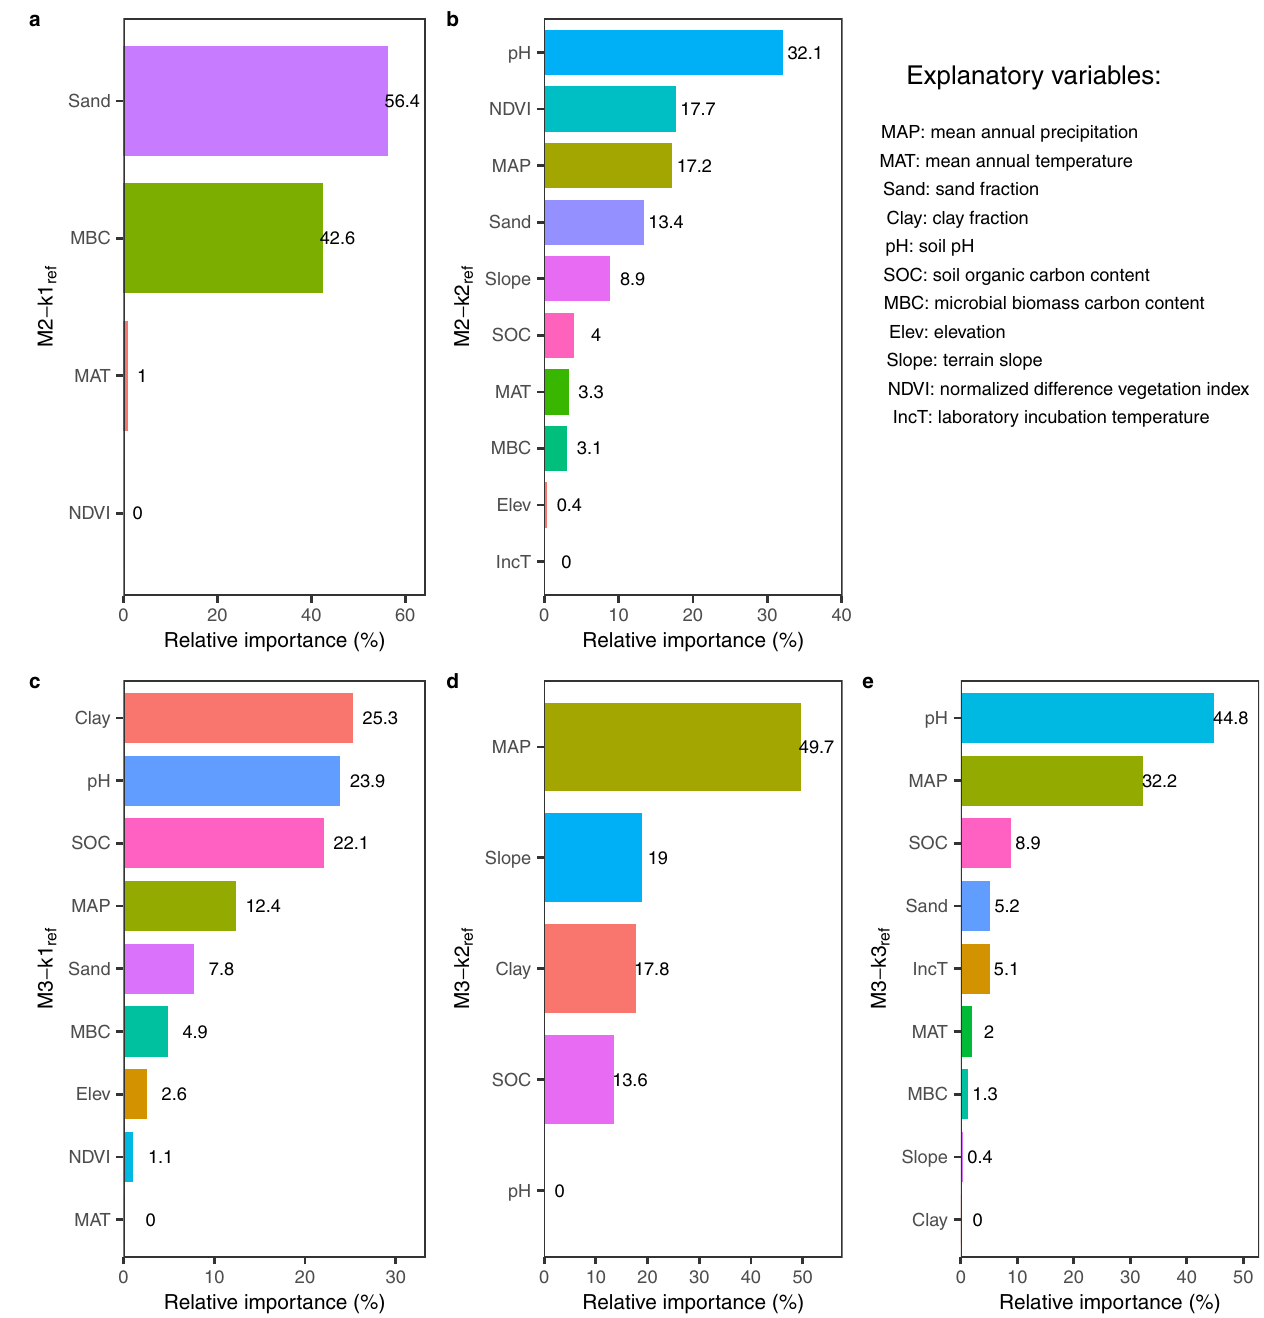
Fig. 3 | Relative importance of explanatory variables screened out by feature selectioninpredictingthereferencedecompositionrates(k ref )bytheRandom Forest (RF) model. a , b Variable importance of the fast pool (M2-k1 ref ) and slow